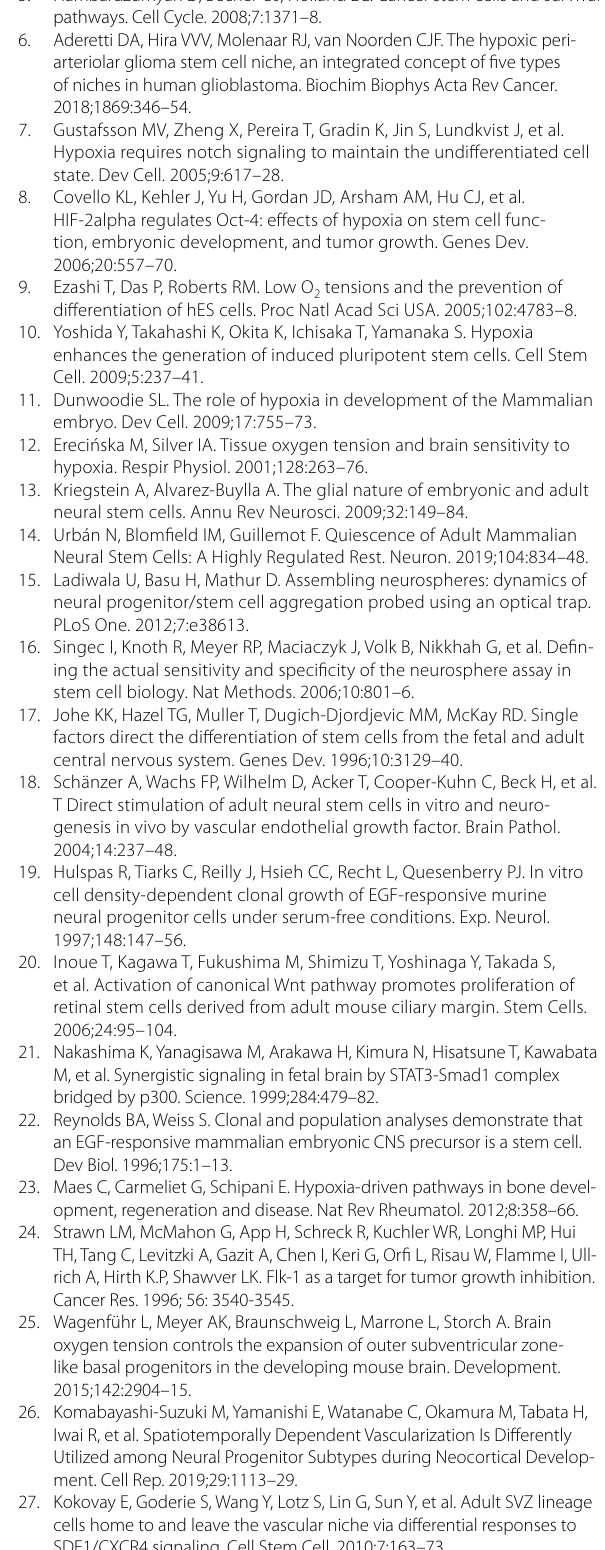
Additional file 13: Figure S13. (related to Fig. 3E and G) VEGF-A secretion in the NSPC culture medium.